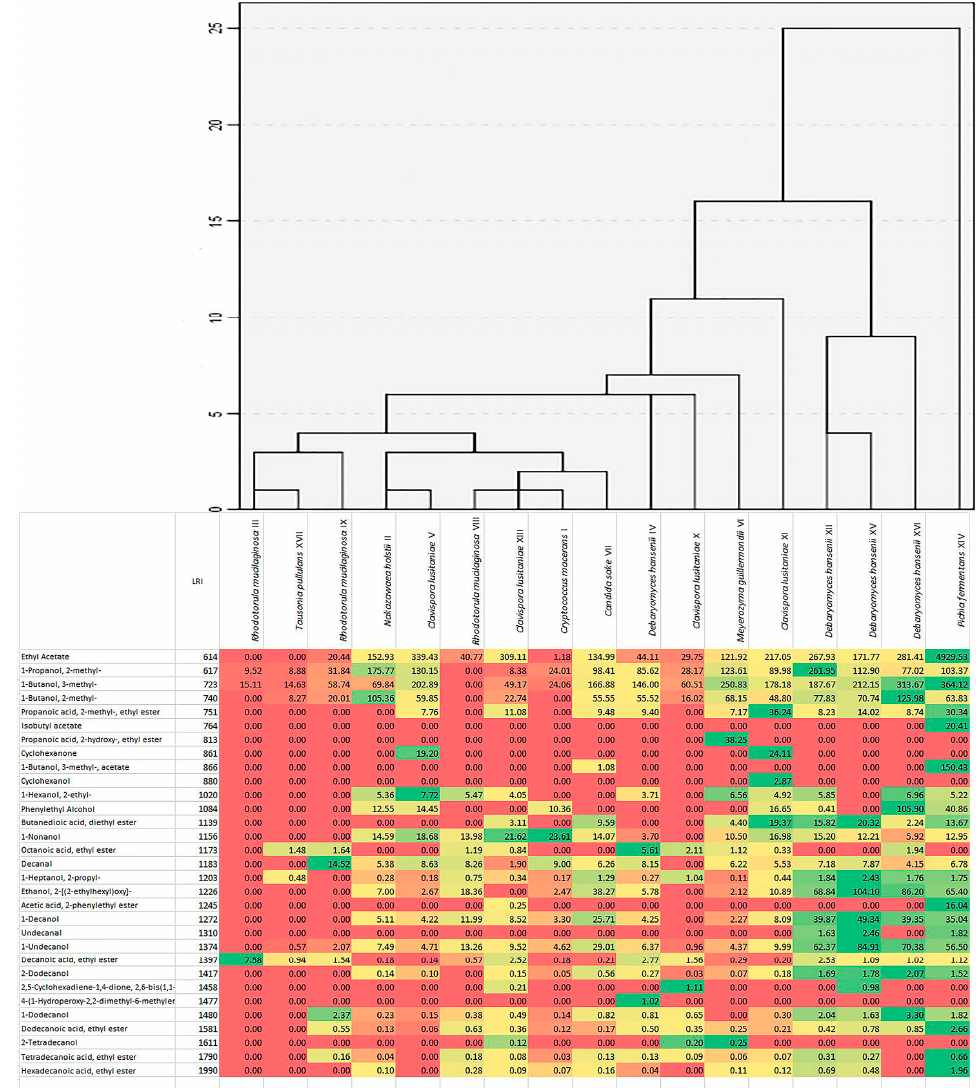
Figure 4. A heat map and cluster analysis results of 31 volatiles [ µ g L − 1 ] produced by yeast isolates from sauerkraut fermentation. The highest content is in the darkest green and the lowest content is in the darkest red.